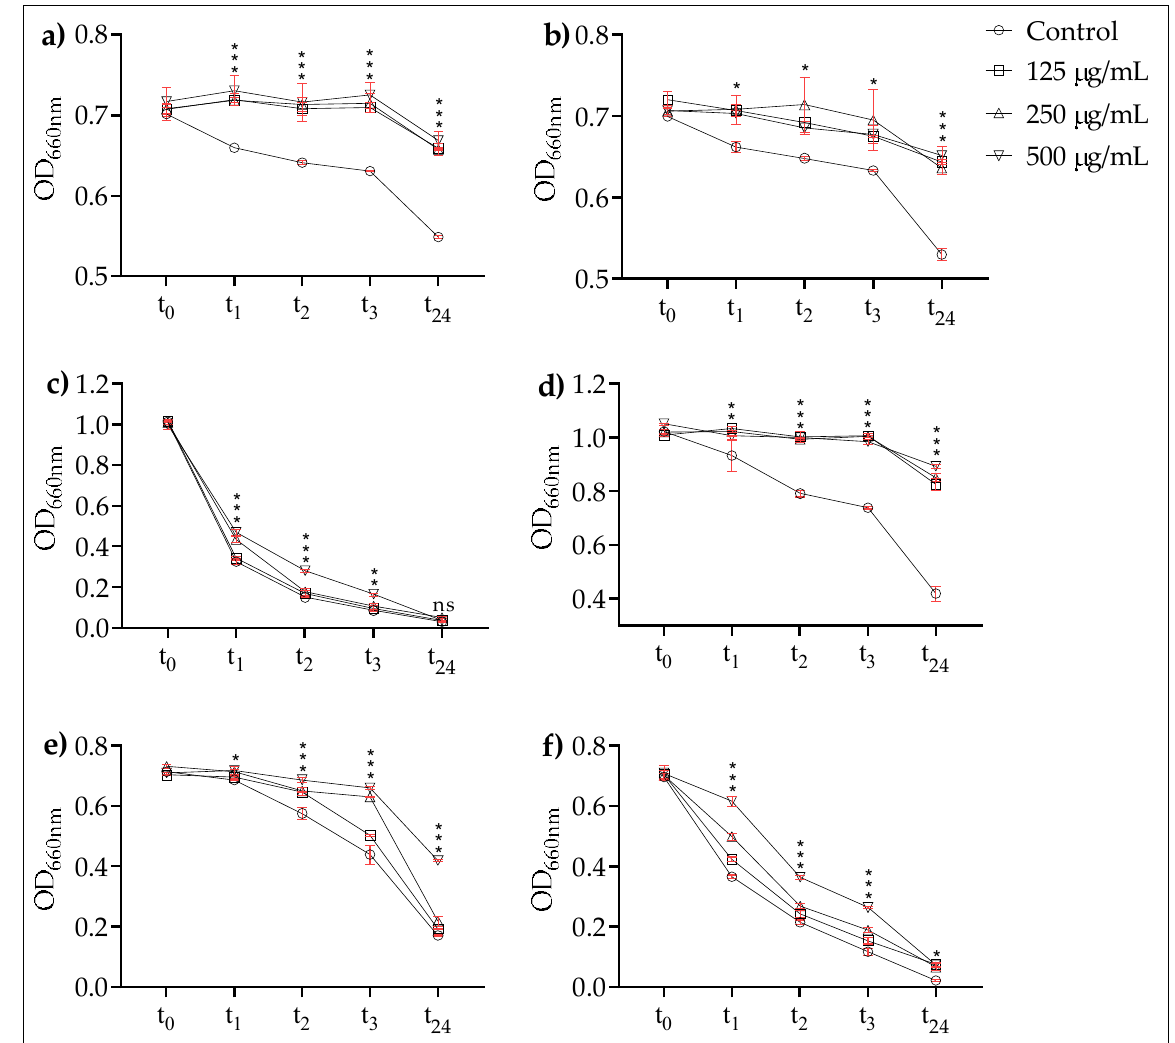
Figure 3. Effects of EPSs on auto-aggregation. ( a ) P. denticola ATCC. ( b ) P. denticola AHN 33266. ( c ) P. gingivalis ATCC 33277. ( d ) P. gingivalis AHN 24155. ( e ) Fil. alocis ATCC 35896. ( f ) F. nucleatum